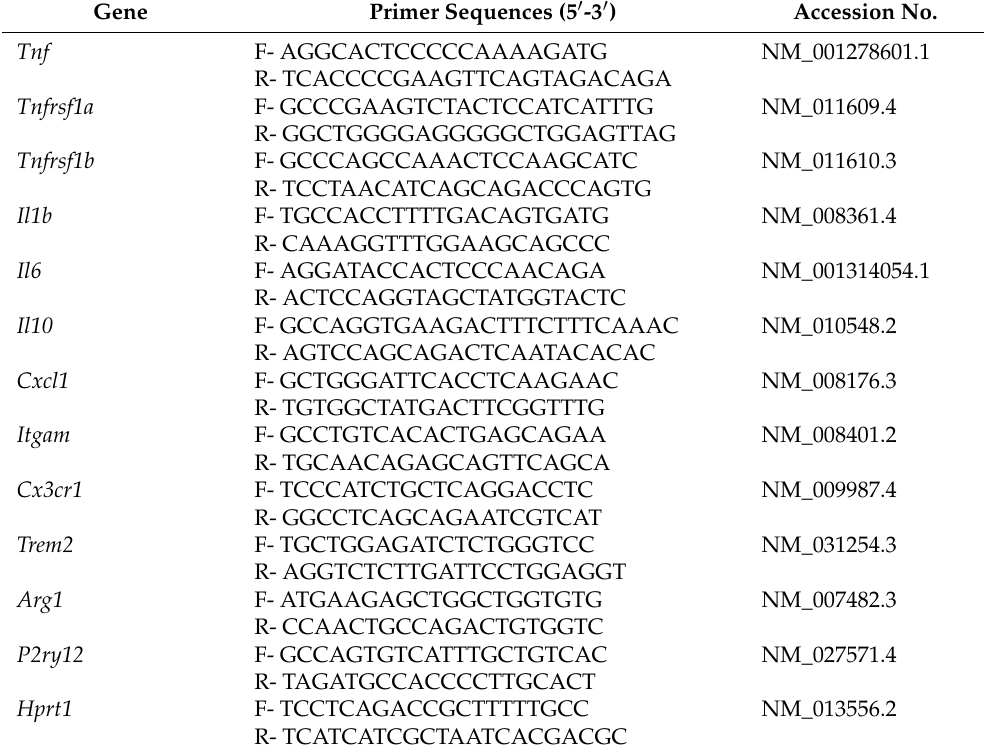
Table 3. Primers used for RT-qPCR